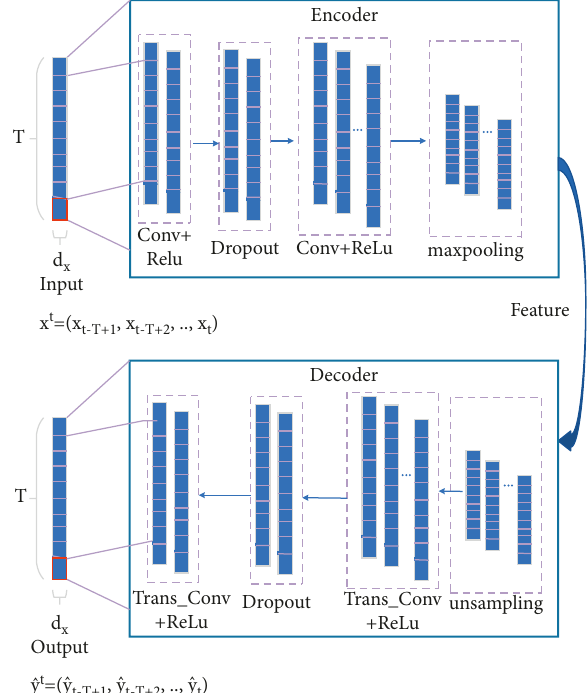
Figure 5: Sliding window one-dimensional convolutional autoencoder model (SW1DCAE).